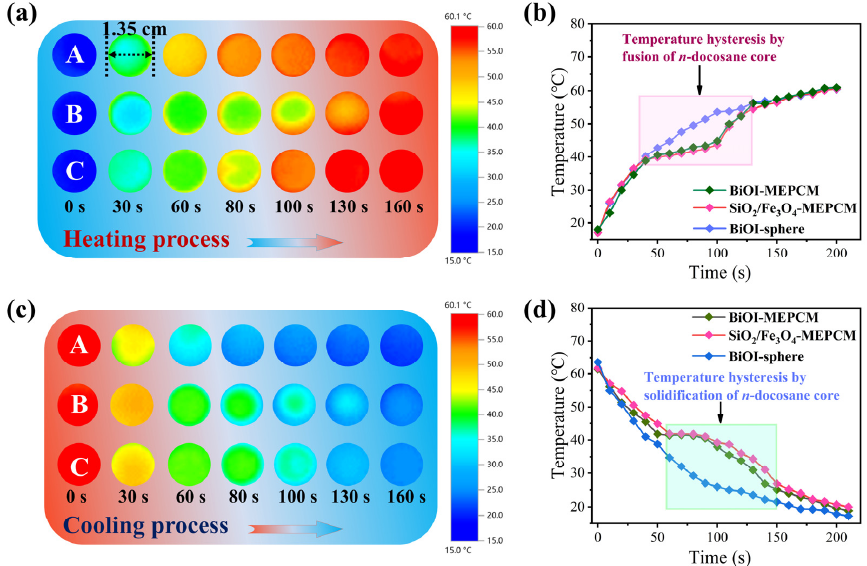
Figure 9. ( a , c ) Representative thermographic images and ( b , d ) temperature evolution of (A) BiOI- sphere, (B) SiO 2 /Fe 3 O 4 -MEPCM, and (C) BiOI-MEPCM during heating and cooling processes.